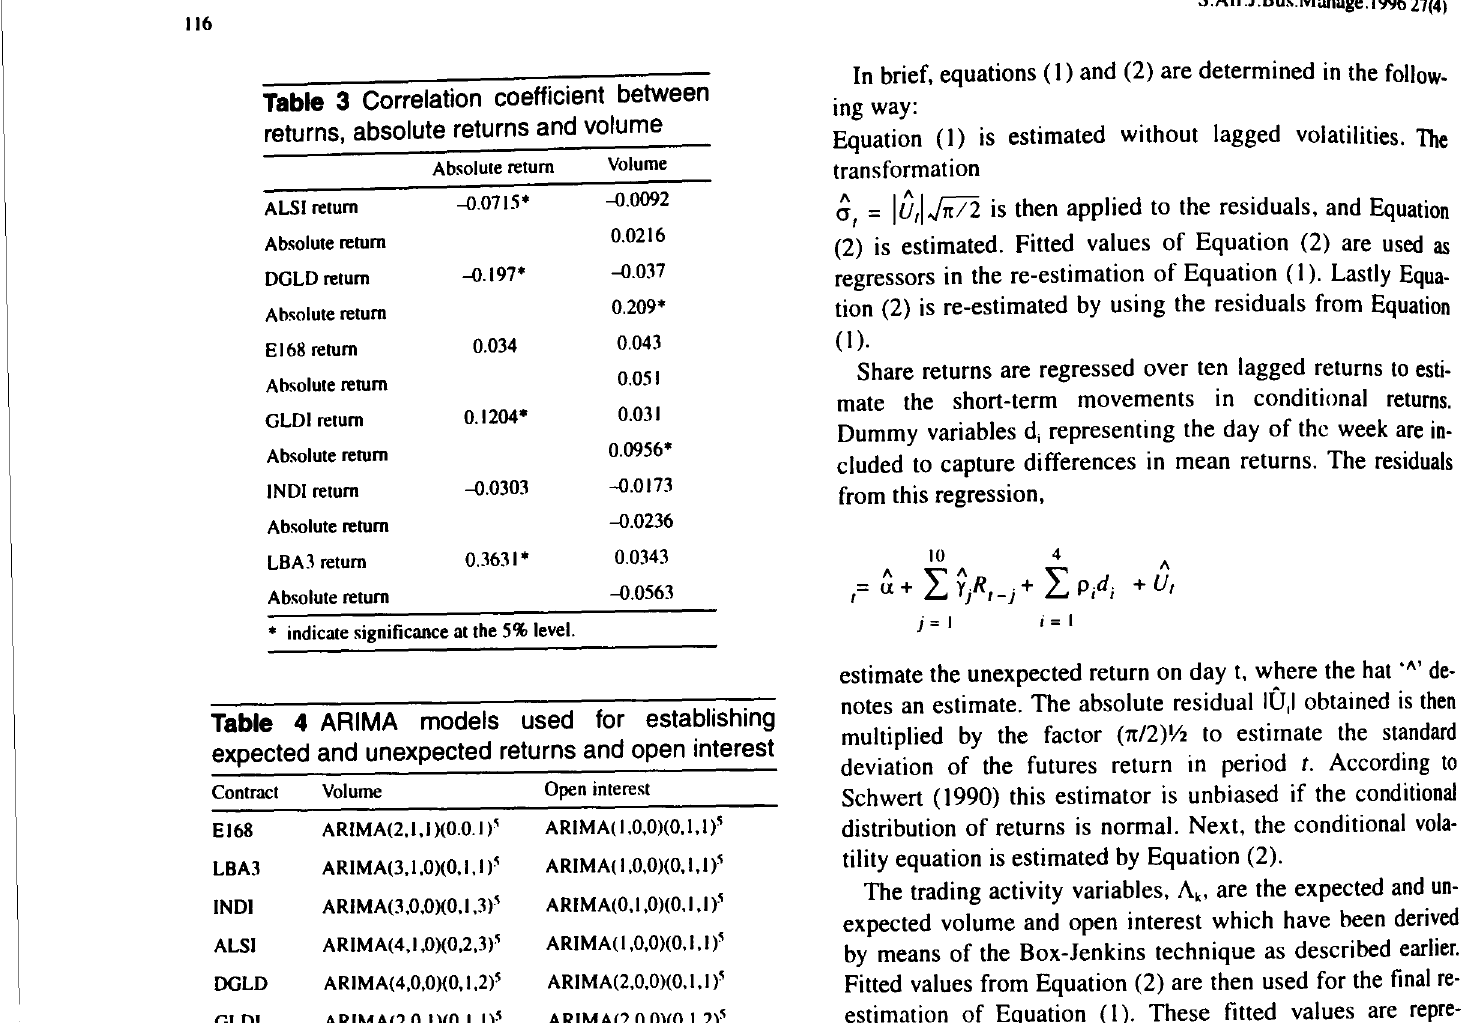
Table 3 Correlation coefficient between returns, absolute returns and volume